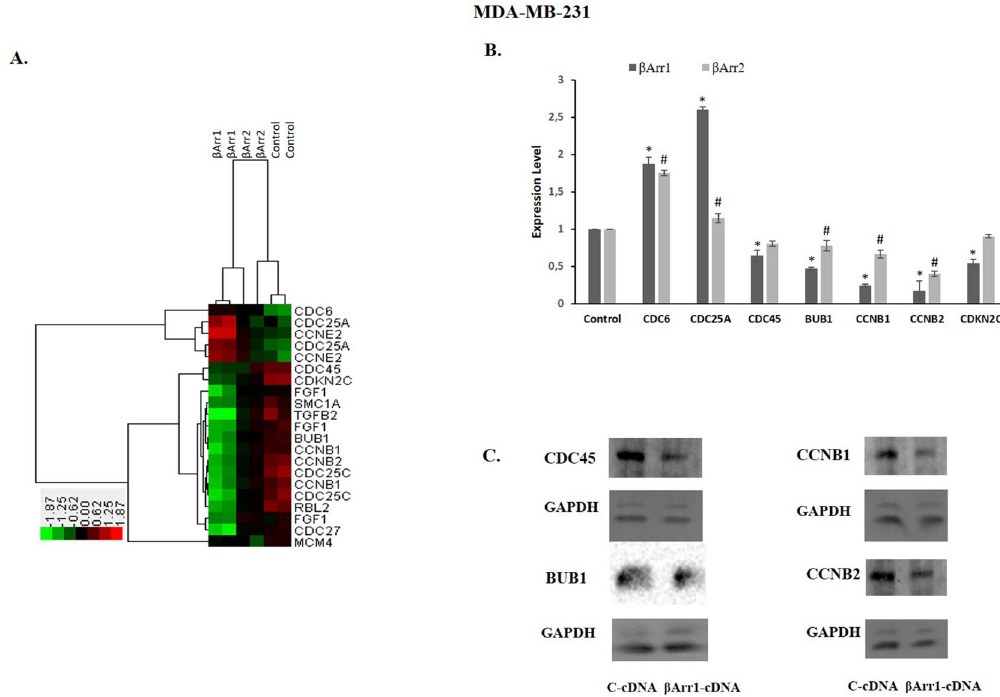
Figure 6. βArr1 or βArr2 overexpression affects cell cycle specific genes. ( A ) Two-way hierarchical clustering analysis was performed for the grouping of samples according to both genes (right panel) and sample types (top panel). The heatmap was visualized by Treeview. The expression profiles of the cell cycle related genes obtained from microarray analysis successfully grouped the βArr1-, and βArr2-overexpressing cells and the control cells when hierarchical clustering was performed. Green boxes represent downregulation, red boxes are used for upregulation and black means no change in the gene expression levels and the expression levels vary between − 1.87 and 1.87 folds in log2 scale. Hierarchical clustering analysis demonstrated that the expression profiles of CDC6, CDC25A, and CCNE2 were upregulated following βArr1 overexpression, and some of the genes like CDC45, BUB1, CCNB1, and CCNB2 were downregulated in those cells. ( B ) The expression profiles of the cell cycle genes were validated by qRT-PCR experiments. The expression profiles of CDC6, CDC25A were upregulated following βArr1 or βArr2 overexpression, CDC45, BUB1, CCNB1, CCNB2 and CDKN2C were downregulated in those cells. Data are presented as mean ± standard error of the mean (* p < 0.05 for βArr1; # p < 0.05 for βArr2 versus C-cDNA). C) The expression of some of the cell cycle genes was also validated in protein level by Western-blot analysis and expression of CDC45, BUB1, CCNB1 and CCNB2 was downregulated in βArr1 overexpressed MDA-MB-231 cell compared to control